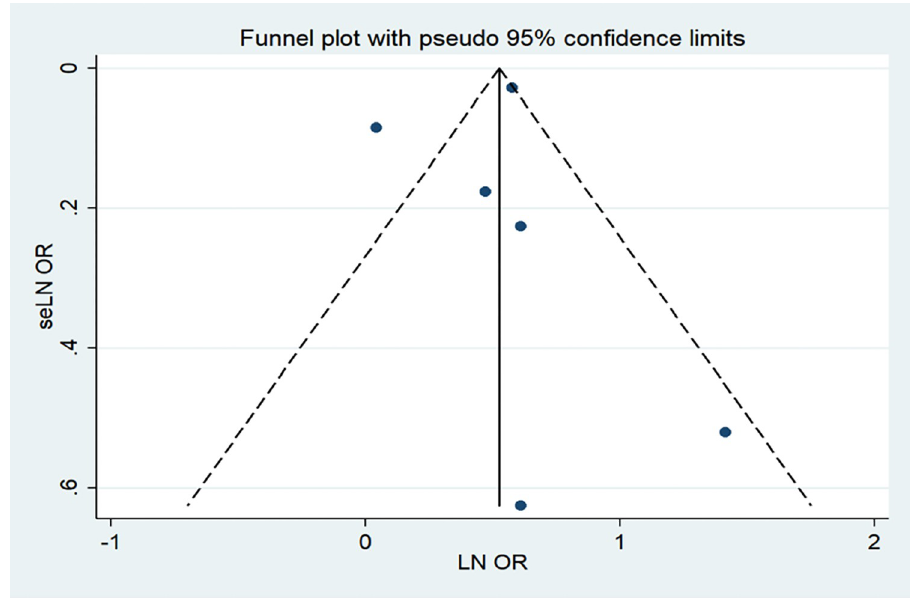
Fig 7. Funnel plot of log relative risk vs. standard error of log relative risks (for OSA and the risk of all-cause